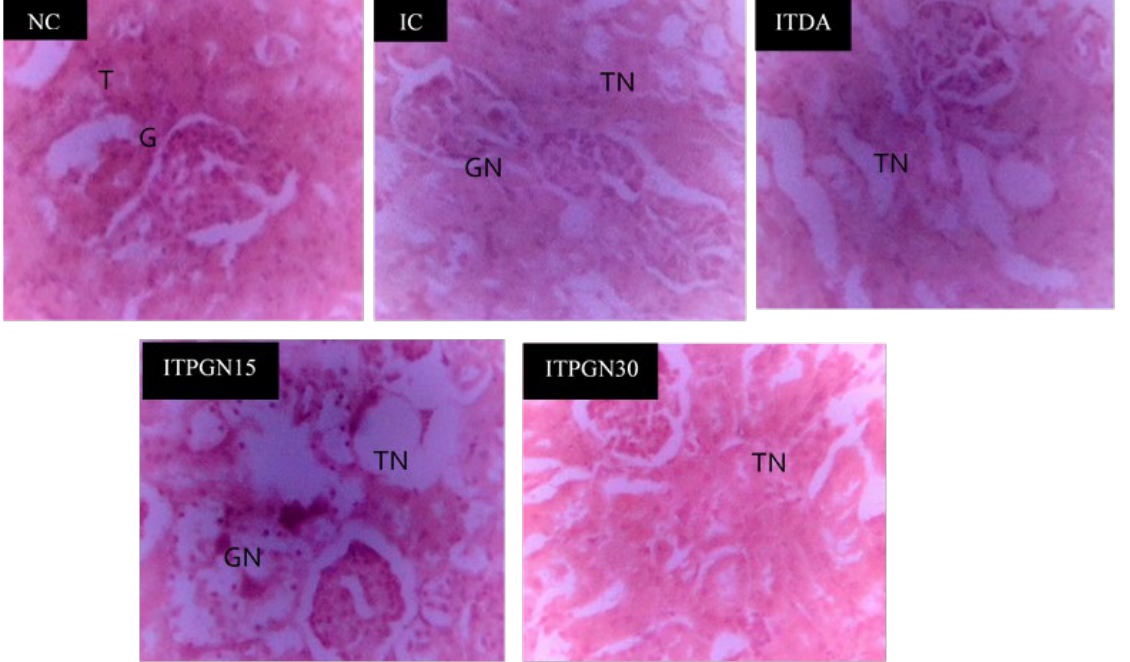
Figure 6. Kidney histopathology of T. congolense -infected rats treated with different doses of phloroglucinol . T = Normal Tubules, G = Normal Glomerulus, GN = Glomerular Necrosis, TN = Tubular Necrosis. NC = Normal control, IC = Infected control, ITPGN15 = Infected + 15 mg/kg BW PGN, ITPGN30 = Infected + 30 mg/kg BW PGN, ITDA = Infected + 3.5 mg/kg BW DA.